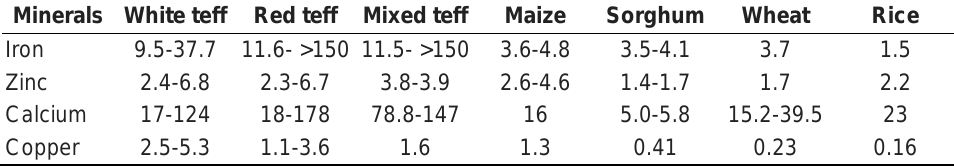
Table 3.2 — Mineral content of teff grain compared to other cereals,